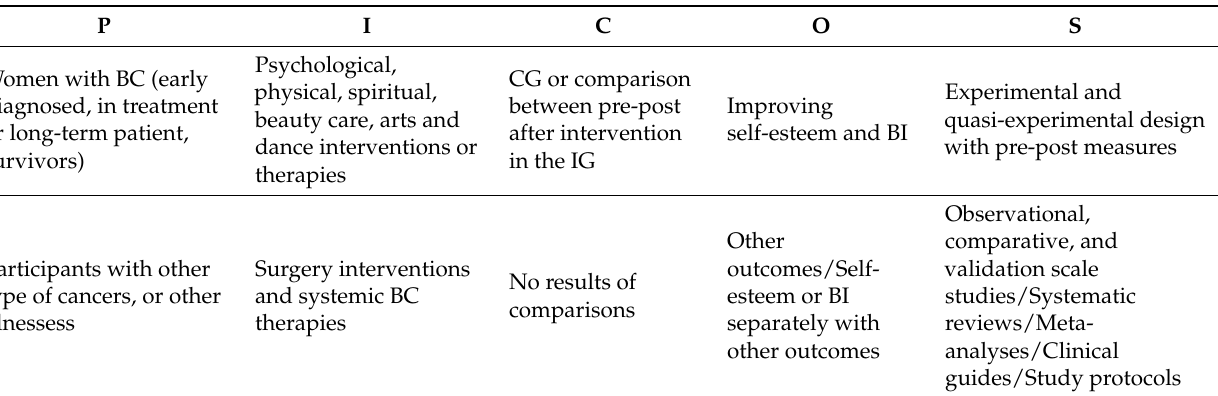
Table 2. PICOS: Participants, Interventions, Comparisons, Outcomes, and Study